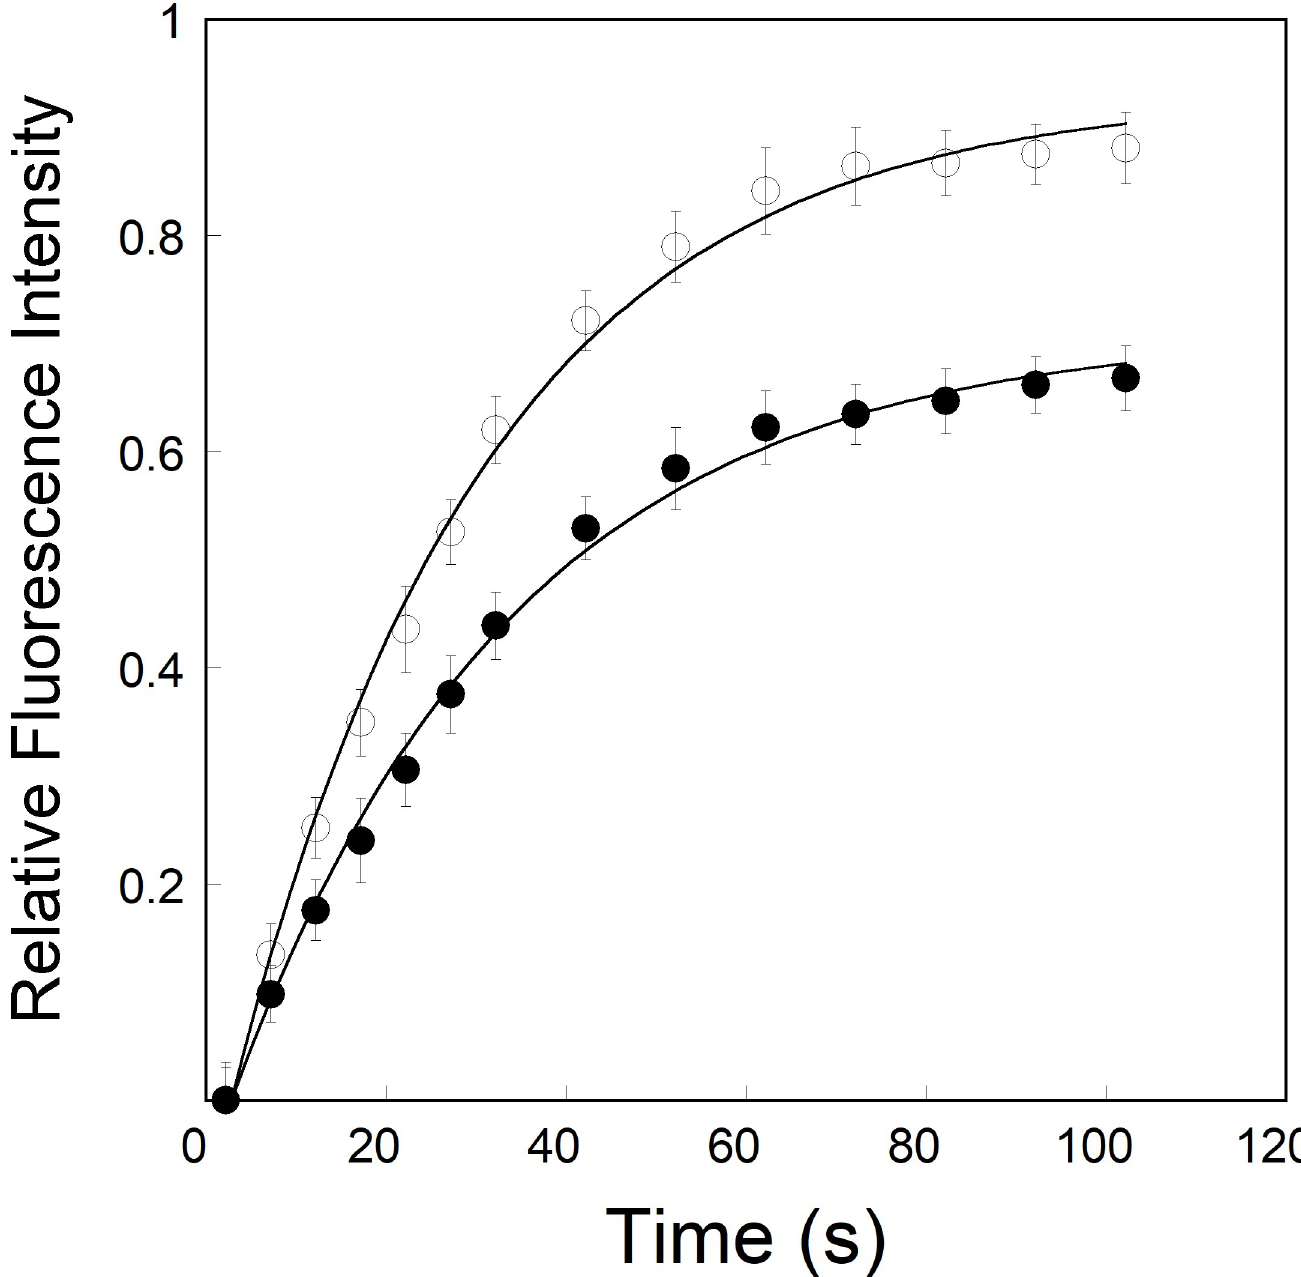
Fig 5. Dissociation kinetics of VPg from pre-formed eIFiso4Ep � VPg complex. Dissociation rate ( k -2 ) constant were monitored by rapidly diluting 100 μ l of the complex eIFiso4Ep � VPg (—•—) or eIFiso4E � VPg (—o—) with 900 μ l of titration buffer at 298 K. VPg and eIFiso4Ep or eIFiso4E concentrations were 10 μ M and 1 μ